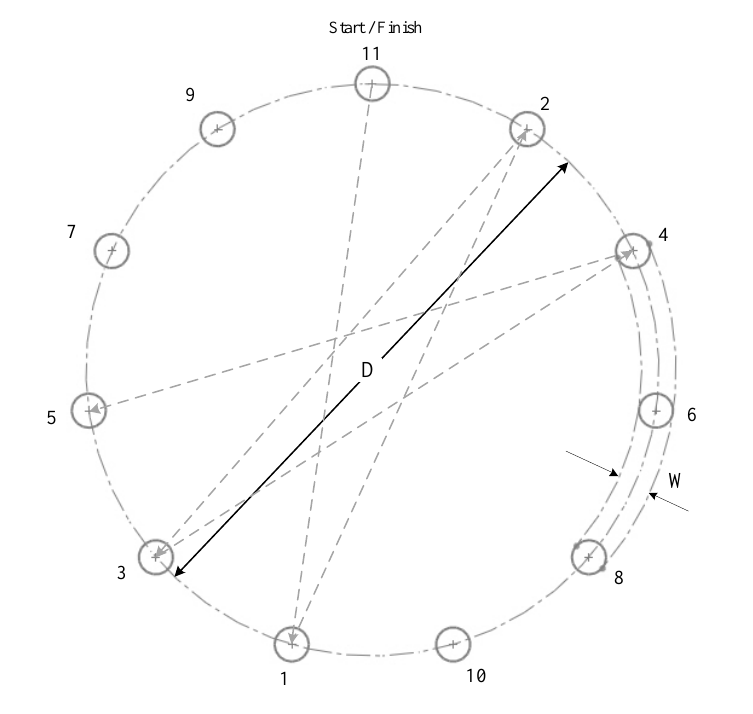
Figure 6. Missions: Participants pointed from Target 1 to Target